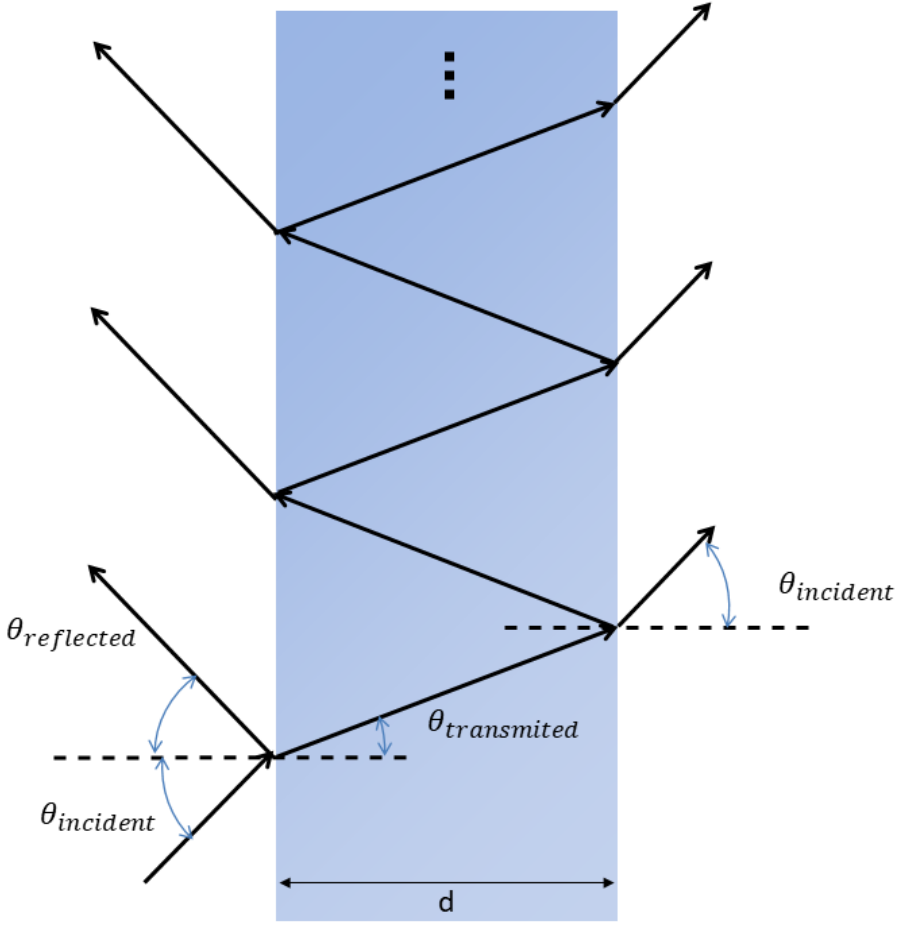
Figure 3. Plane wave incident on a slab of thickness d.